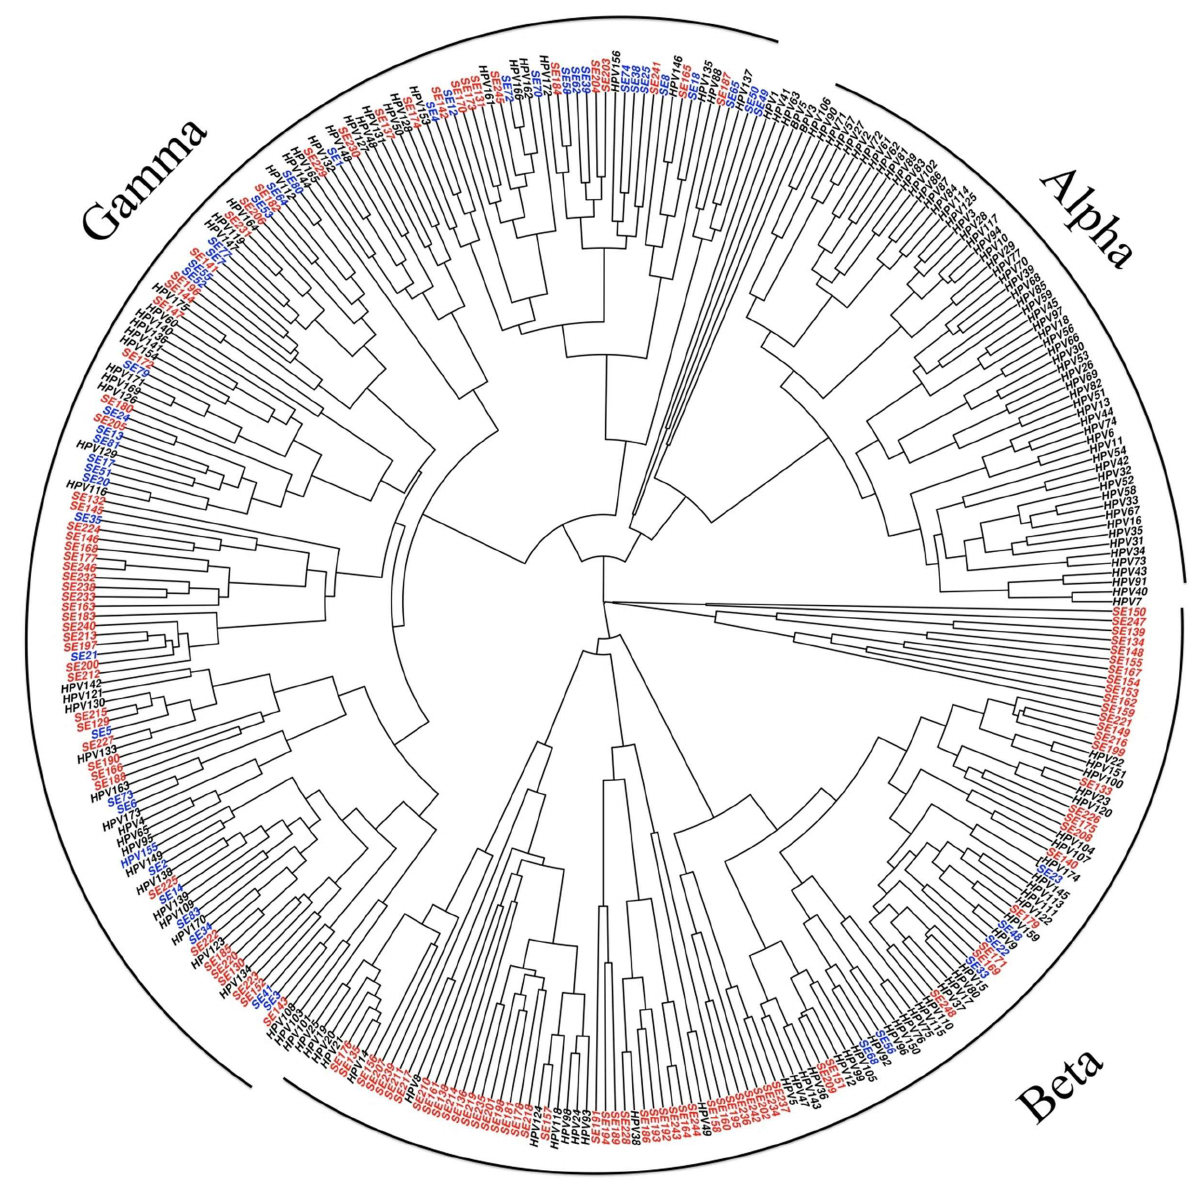
Figure 1. A Bayesian phylogenetic tree based on the L1 gene. From Bzhalava et al.